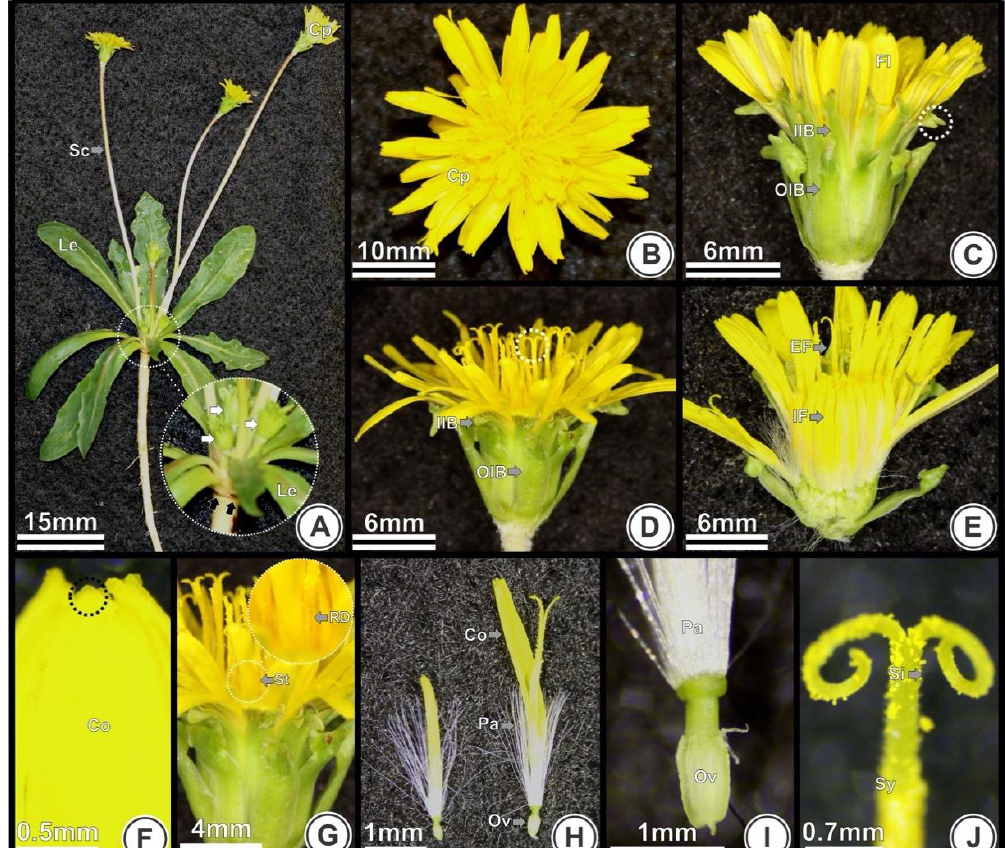
Figure 1. Flower and inflorescence morphology in Taraxacum kok-saghyz . Different views of the inflorescences ( A – E ) and flowers ( F – J ) under digital camera ( A , B ) and stereomicroscope ( C – J ). ( A ) Plant with rosette leaves and solitary capitulum on each scape. Newly formed inflorescences (white arrow) and leaves insertion (black arrow) showed in detail; ( B ) Top view: homogamous capitulum; ( C ) Lateral view: flowers protected by the inner and outer involucral bracts, pointed edges on inner involucral bracts (white circle); ( D ) Lateral view: styles and stigmas (white circle) and involucral bracts; ( E ) Longitudinal section: inner flowers closed and external flowers opened; ( F ) Lateral view: toothed corolla (black circle); ( G ) Epipetalous stamens with rimose dehiscence (in detail); ( H ) Lateral view: corolla, pappus ring and inferior ovary; ( I ) Detail of the ovary and pappus; ( J ) Lateral view of a bifid style and stigma. Abbreviations: Co, corolla; Cp, capitulum; Fl, flowers; IIB, inner series of involucral bracts; Le, leaves; Ov, ovary; OIB, outer series of involucral bracts; Pa, pappus; RD, rimose dehiscence; Sc. scapes; Si, stigma; St, stamens; Sy, style.